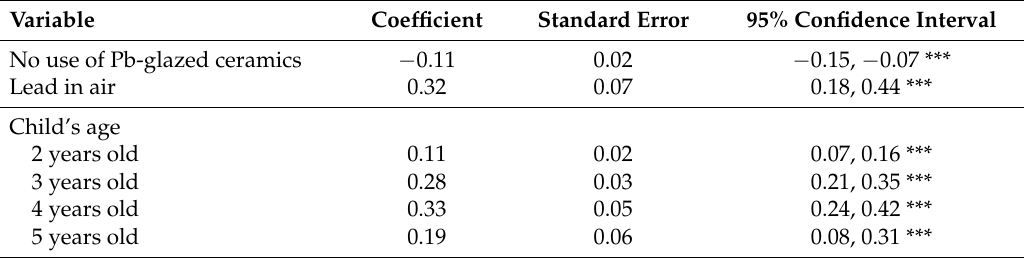
Table 3. Results of the mixed model for the log of children’s blood lead concentrations. Variable